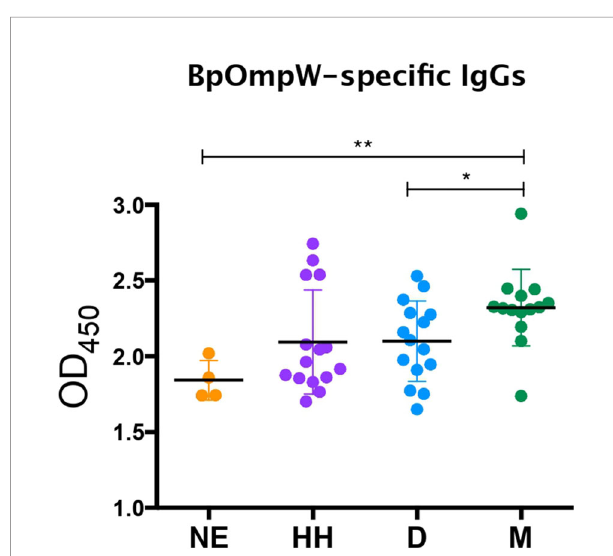
FIGURE 7 | BpOmpW-speci fi c immunoglobulin G (IgG) responses in plasma from melioidosis survivors. Detection by ELISA of the BpOmpW-speci fi c IgGs in plasma from different cohorts: NE , non-endemic ( n = 3); HH , healthy householders ( n = 15); D , healthy diabetics ( n = 15); M , melioidosis diabetic survivors ( n = 15). BpOmpW , homologue OmpW in Burkholderia pseudomallei Asterisks mark signi fi cant differences according to two-tailed Student ’ s t -test. The levels of signi fi cance are represented as follows: * p < 0.05; ** p < 0.01.